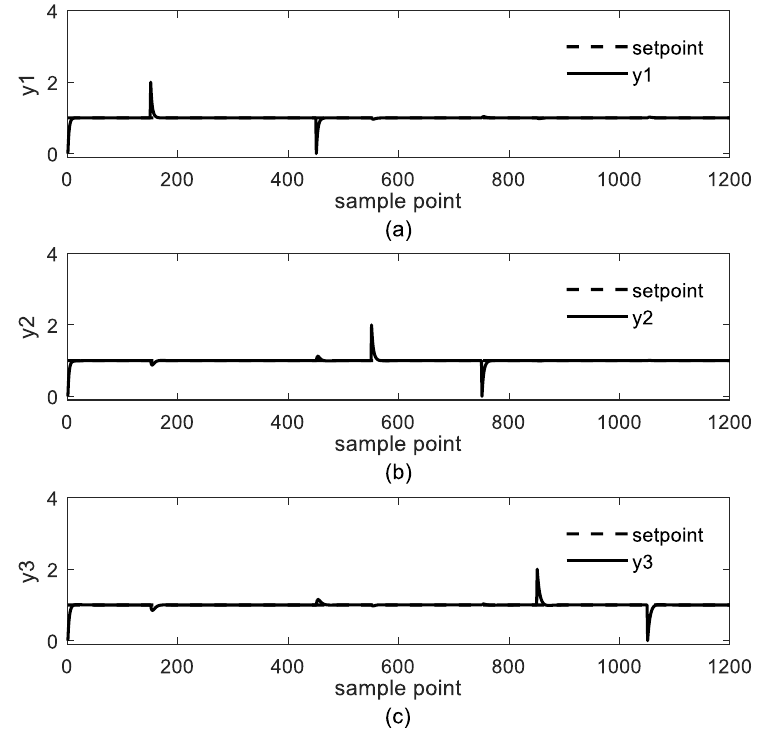
Figure 14. The simulation result of OSDP1 without noise: ( a ) y 1 —production; ( b ) y 2 —slurry polymer; ( c ) y 3 —catalyst efficiency.